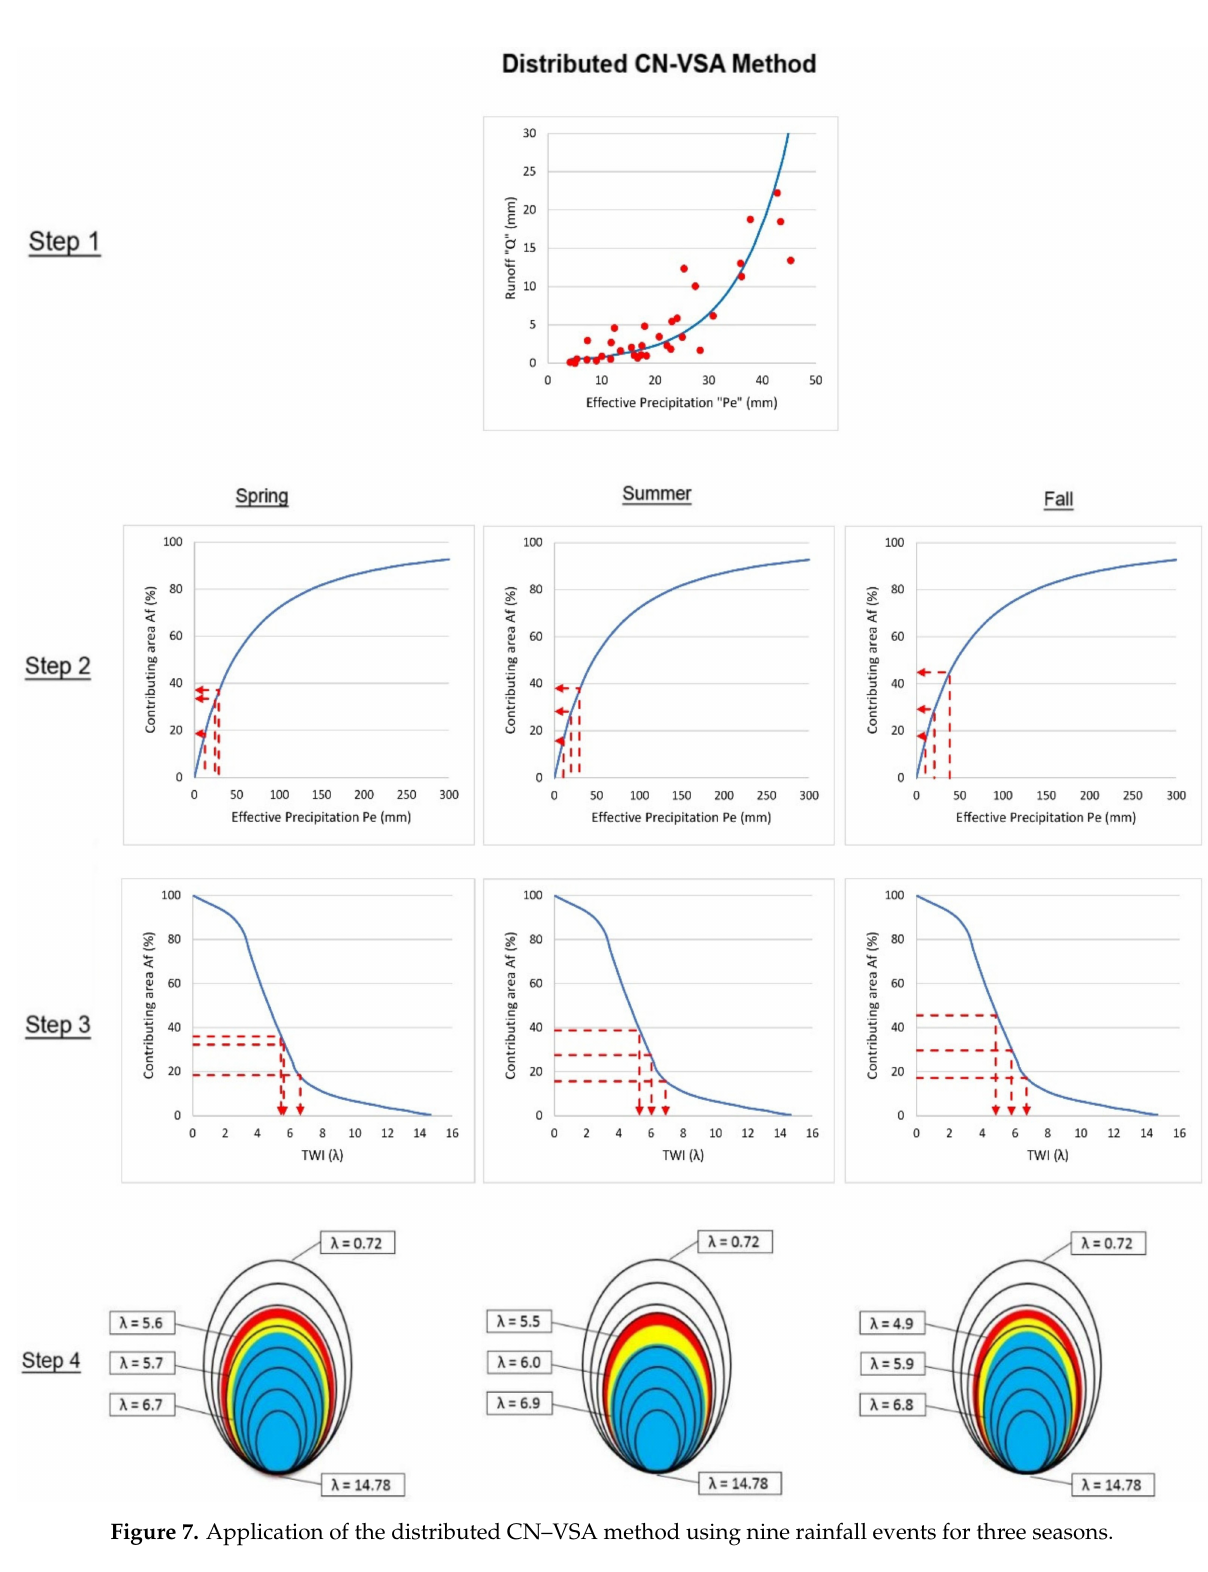
Figure 7. Application of the distributed CN–VSA method using nine rainfall events for three seasons. For example, during a spring event on 3 May 2012, 29.70 mm of rainfall P resulted in 27.52 mm of P e (Table 1). The average S value of 112 mm was determined by fitting Equation (3) to observed event runoff corresponding to event P e (Figure 7, step 1). The P e value of 27.52 mm corresponds to A f = 33% of the total watershed area, as shown in step 2 of Figure 7. The A f value of 33% (7.13 ha) as determined in step two corresponded to a threshold λ value of 5.7 using a graph of λ versus A f for the study watershed (Figure